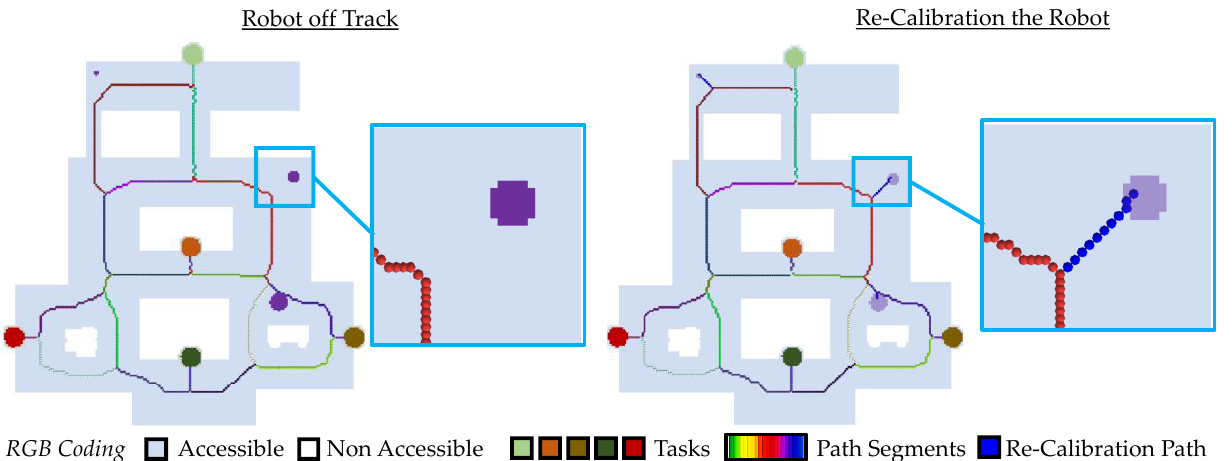
Figure 15. Repositioning the robot: map with the robot not on track, repositioning path for the robot.